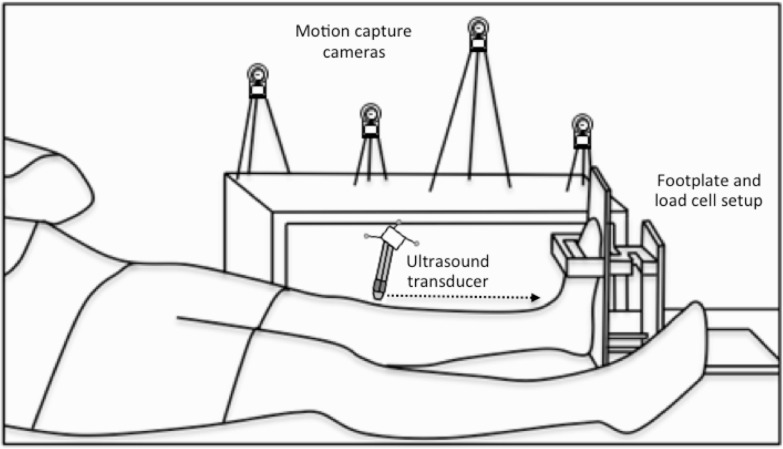
Experimental setup.A schematic of the footplate and load cell setup and the participant’s position during the three-dimensional (3D) ultrasound scans, which combined B-mode imaging of the left-sided tibialis anterior muscle with 3D motion capture of the ultrasound transducer’s position and orientation. Single transverse sweeping scans were performed from the proximal to distal (indicated by the horizontal dotted arrow) or distal to proximal direction at rest and during sustained isometric dorsiflexion contractions.